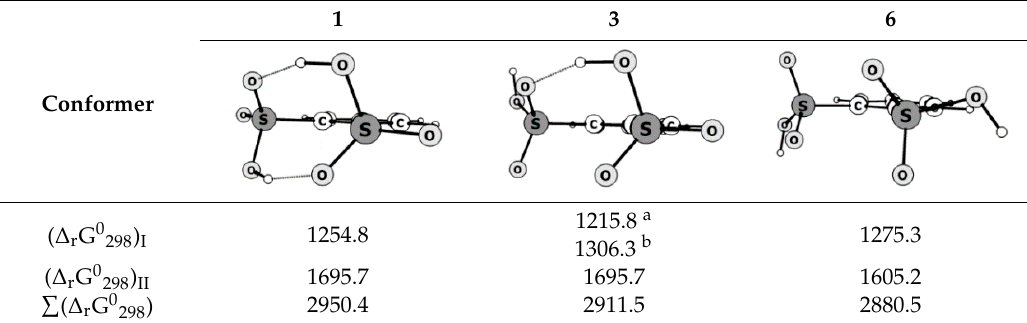
Table 5. Gibbs energies of GD of di ff erent conformers 2-SO 3 H-BSA (kJ mol − 1 ) in two stages. Table 5. Gibbs energies of GD of different conformers 2-SO 3 H-BSA (kJ mol − 1 ) in two stages. Table 5. Gibbs energies of GD of different conformers 2-SO 3 H-BSA (kJ mol − 1 ) in two stages. Table 5. Gibbs energies of GD of different conformers 2-SO 3 H-BSA (kJ mol − 1 ) in two